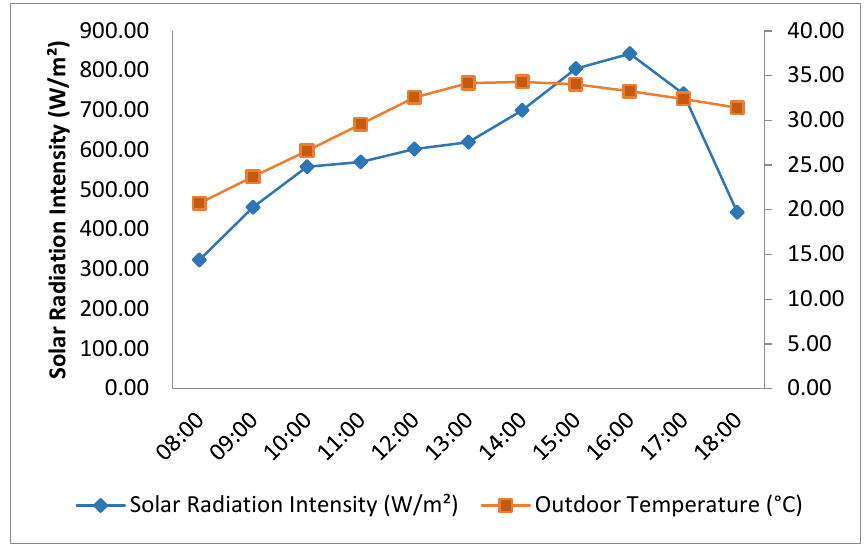
Figure 6 Solar radiation intensity and outdoor temperature for August 14 in Kayseri.